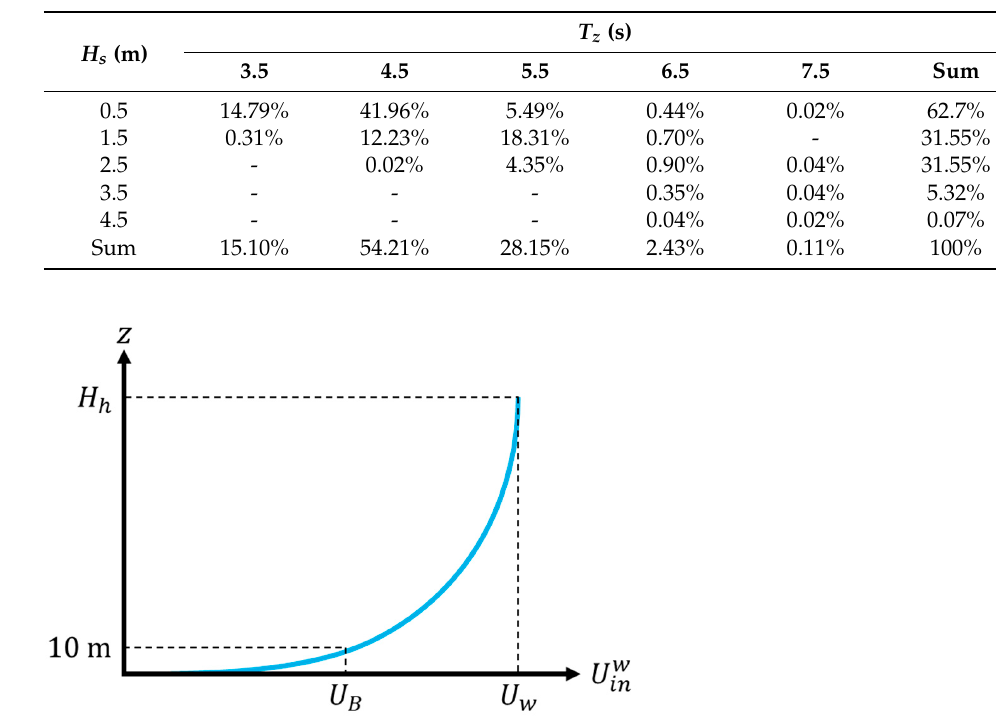
Table 4. Wave scatter diagram of Hsinchu offshore area.